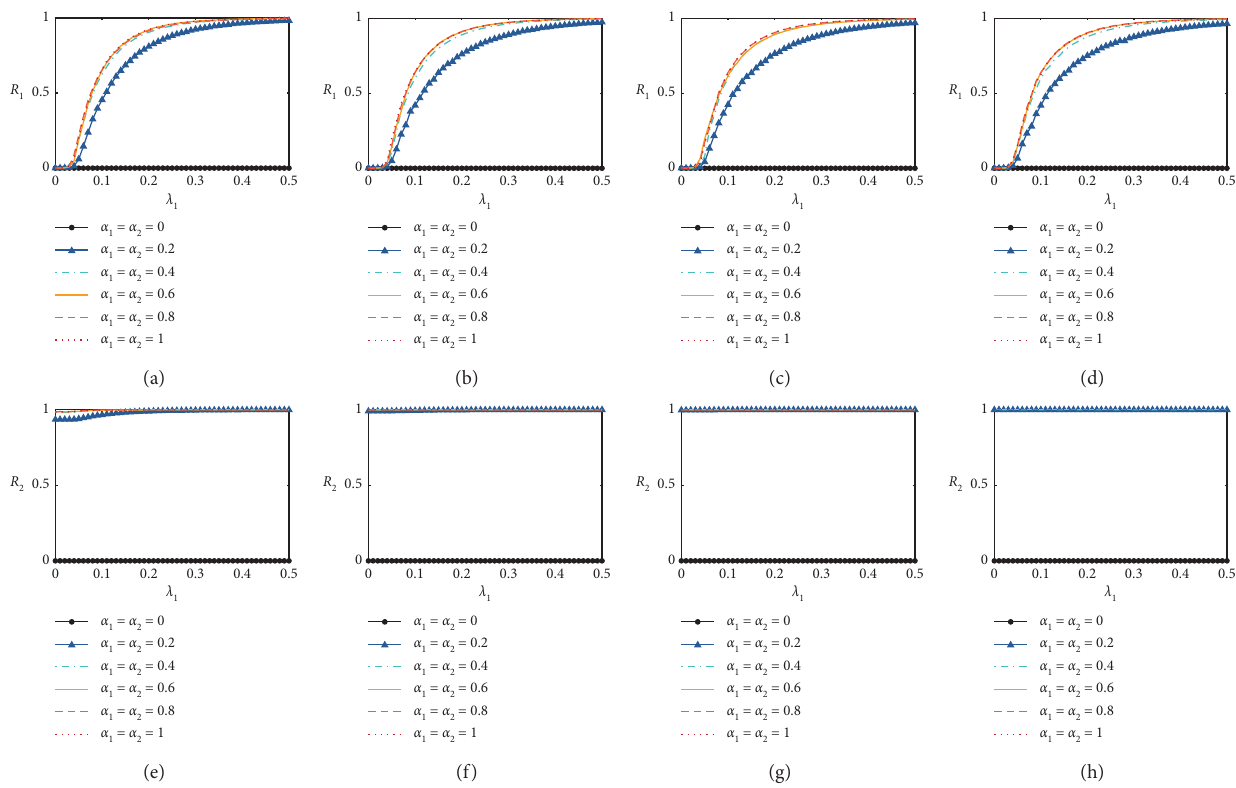
with q � 0 . 5. R 1 � 0 . 6, and (h) λ 2